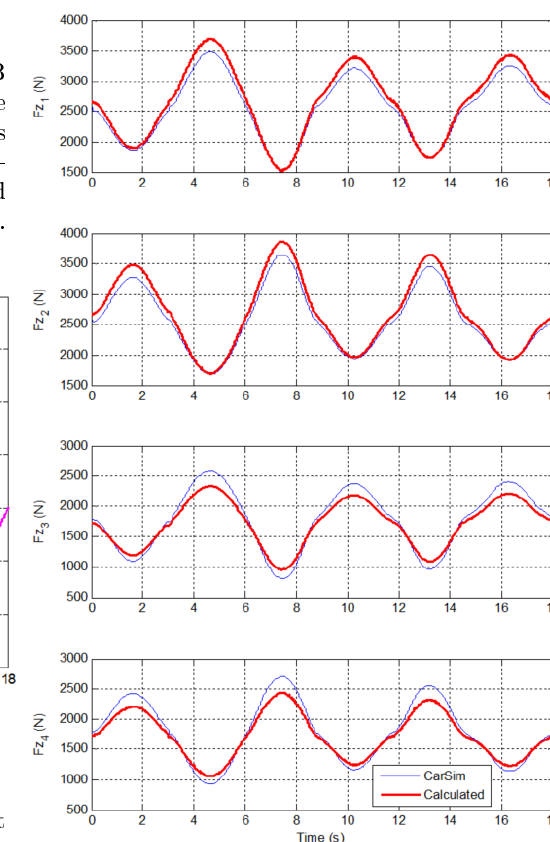
Initially, based on the measurable signals of longitudinal and lateral accelerations, the verti- cal forces were approximately calculated using Eqs. (35)(cid:21)(38). Subsequently, these forces were compared with the standard vertical forces of the CarSim vehicle model as shown in Fig. 5. Eqs. (35)(cid:21)(38) were derived without considering the camber angle and suspension dynamics. The roll and pitch accelerations were not considered.